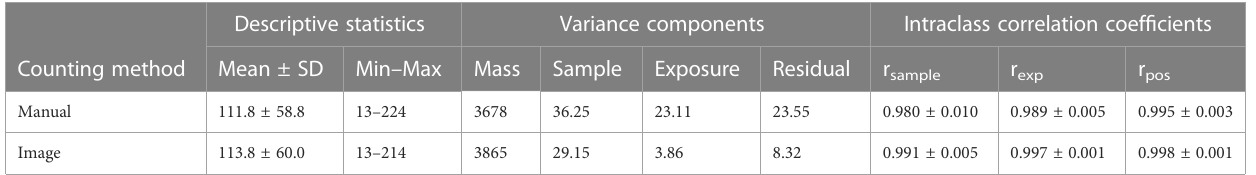
TABLE 1 Descriptive statistics for bead counts using manual and image algorithm counting across the ten different masses of feed, the two X-ray exposure setting s , and the positioning of the two feed samples on the X-ray plate.